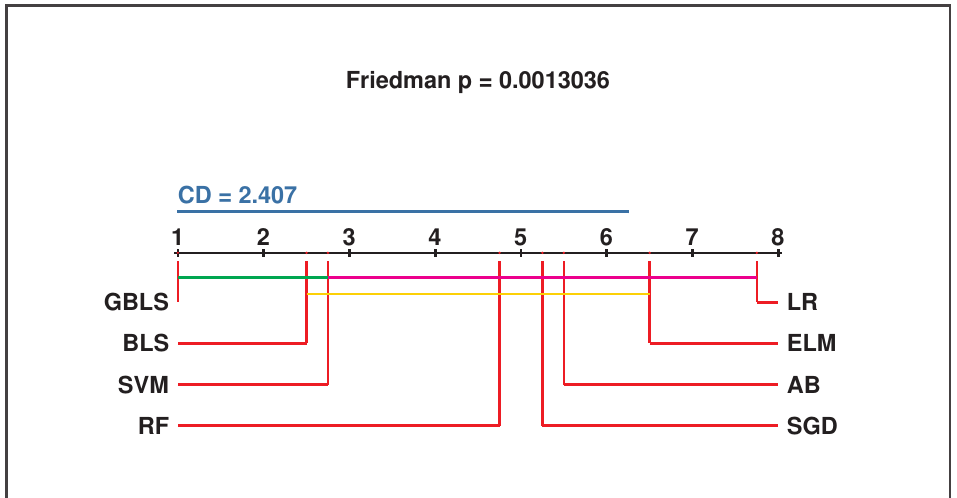
Figure 7. Nemenyi test for model capacity. Yellow line indicates that no significant difference between connected models, so do green and purple lines. The smaller the number, the higher the rank.